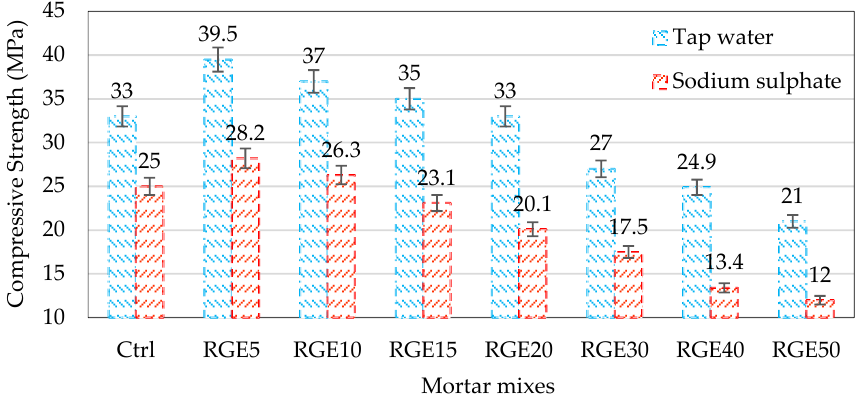
Figure 16. Compressive strength at 120 days (tap water and 20% sodium sulphate attack).